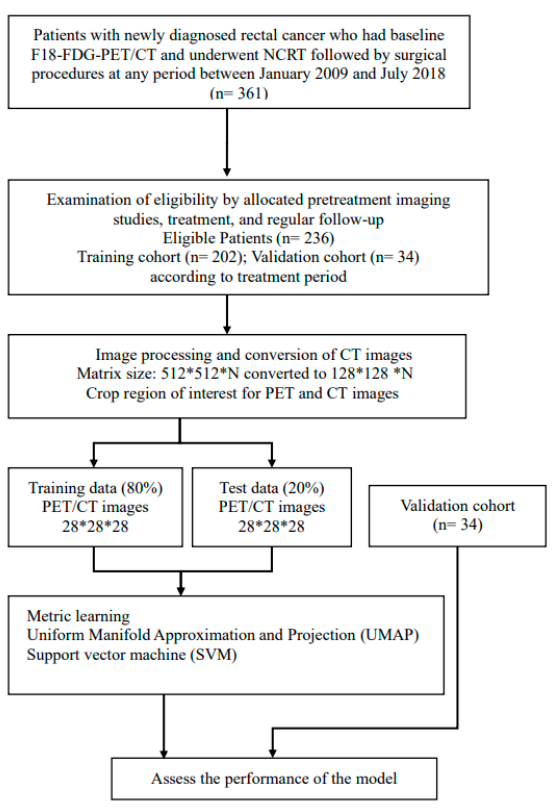
Figure A1. Flowchart of study design.